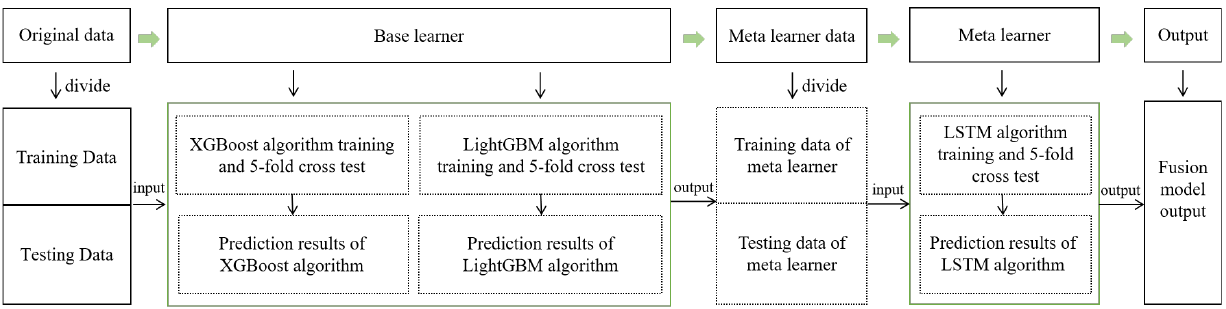
Figure 3. The fusion model (BXGB-BLGB-GLSTM) architecture